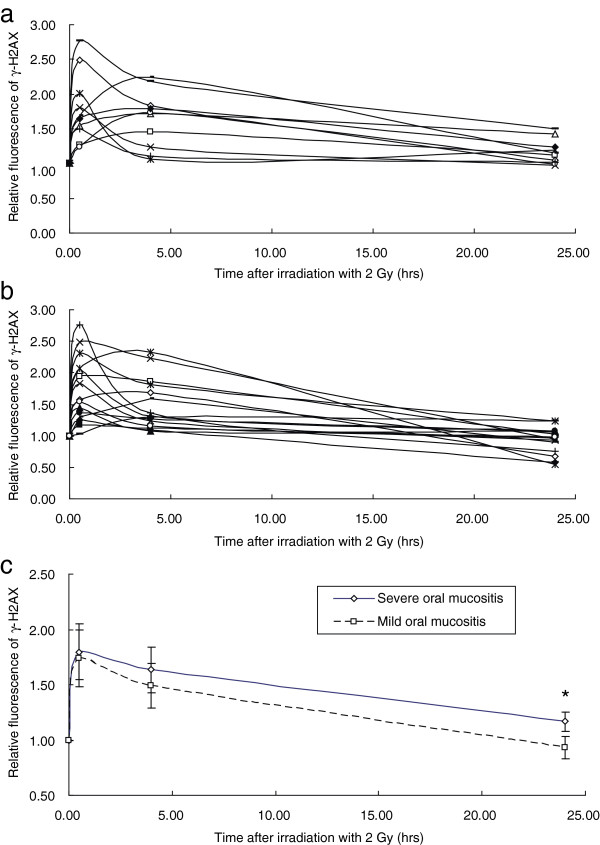
The time-dependent accumulation of irradiation-induced γ-H2AX in PBLs in vitro. The γ-H2AX fluorescence was measured using a FACS-based assay in PBLs isolated from 15 patients mild OM (a) and 10 patients with severe OM (b) at 0, 0.5, 4, and 24 hours after in vitro exposure to 2 Gy of X-ray radiation. (c) The mean level of the relative fluorescence for patients with severe OM (diamonds) and mild OM (squares); *p <0.05.